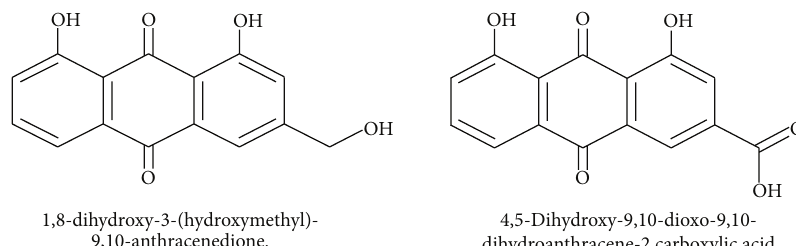
Scheme 1: Structures of aloe emodin and its carboxylic acid